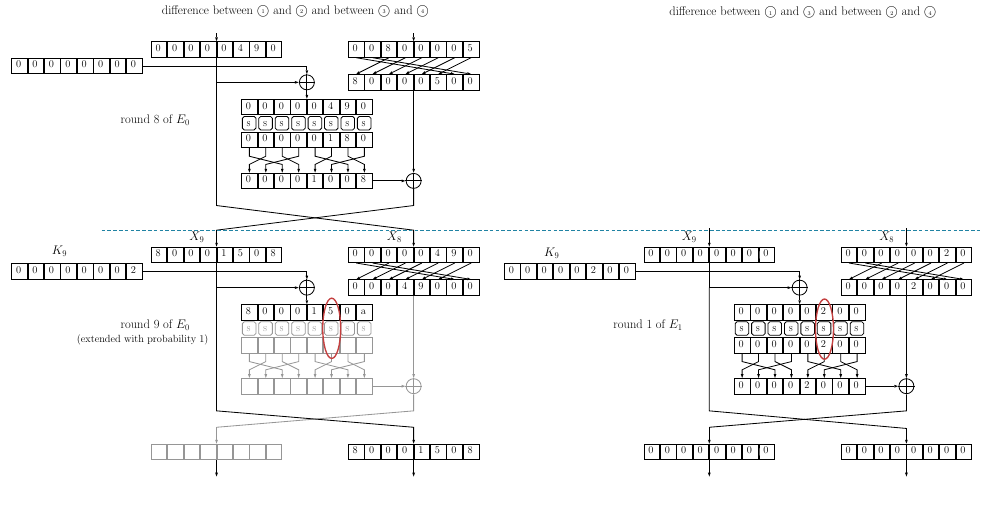
Figure 3: Middle rounds of the boomerang distinguisher proposed in